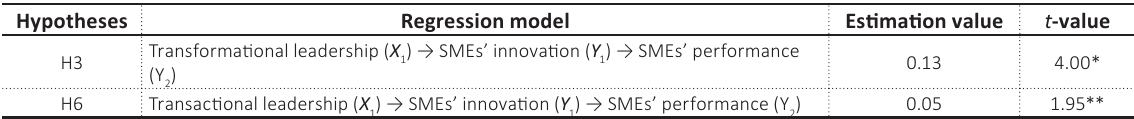
Table 4. Hypothesis testing results from indirect